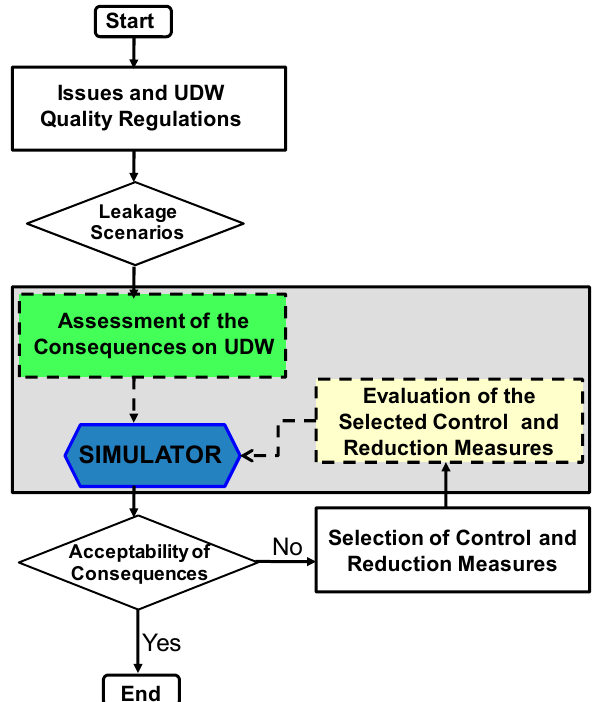
Figure 1. Framework to predict and to assess the potential consequences of CO 2 leakage on the quality of underground drinking water (UDW) as well as assess the efficiency of groundwater mitigation methods and scenarios.